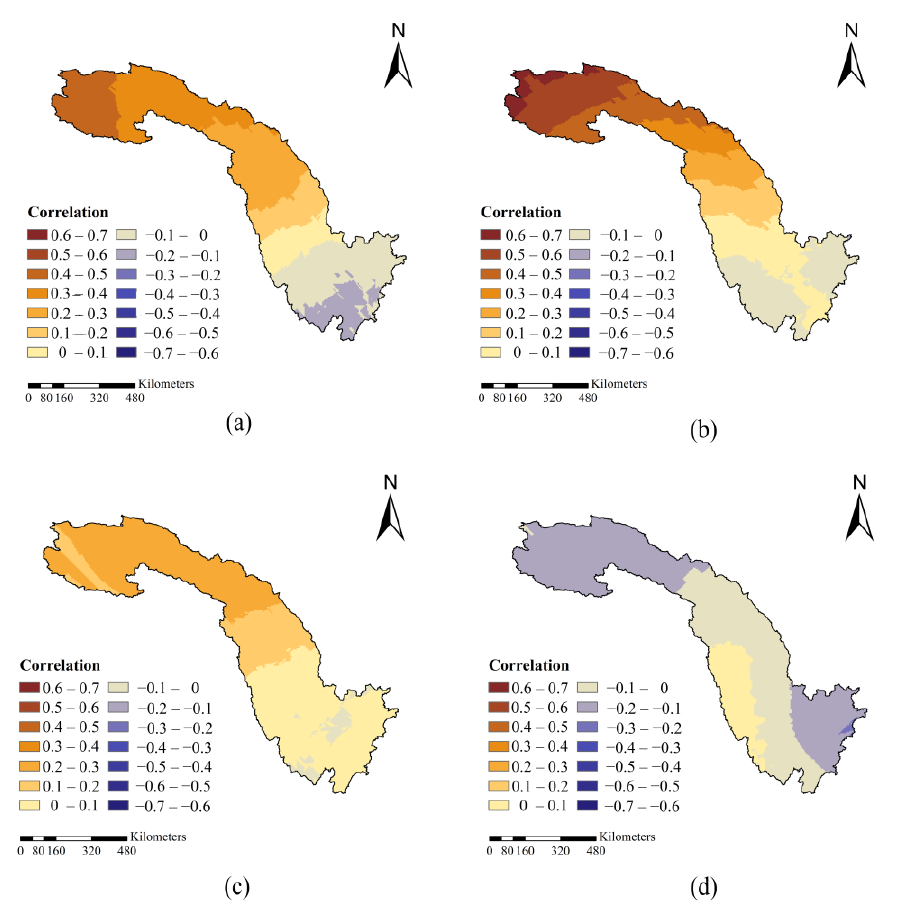
Figure 13. Spatial distribution of the correlation between seasonal minimum temperature and precipitation during ( a ) spring, ( b ) summer, ( c ) autumn, and ( d ) winter.